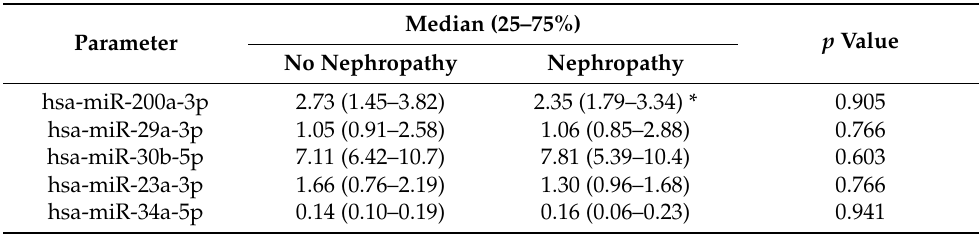
Table 6. Fold changes in miRNAs expression in patients without ( n = 9) and with ( n = 11) Fabry nephropathy at last